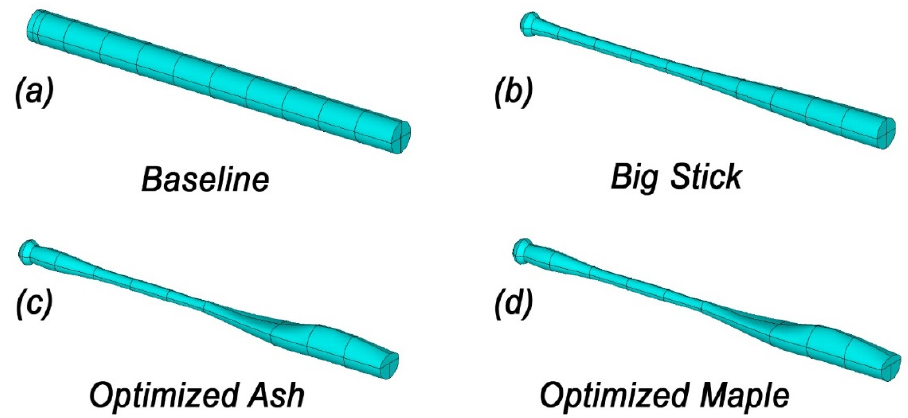
Figure 9. Baseline ( a ), Big Stick ( b ) andthe optimized ash ( c ) and maple ( d ) baseball bats. Table 2 shows the design variables, RMSD and the total mass of the baseline, Big Error! Reference source not found. shows the baseline design, the Big Stick bat and